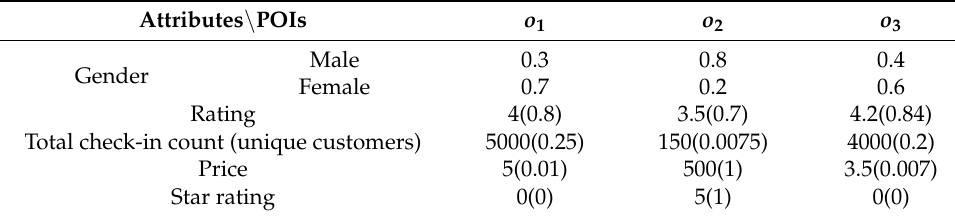
Table 1. Calculation of similarity among discrete